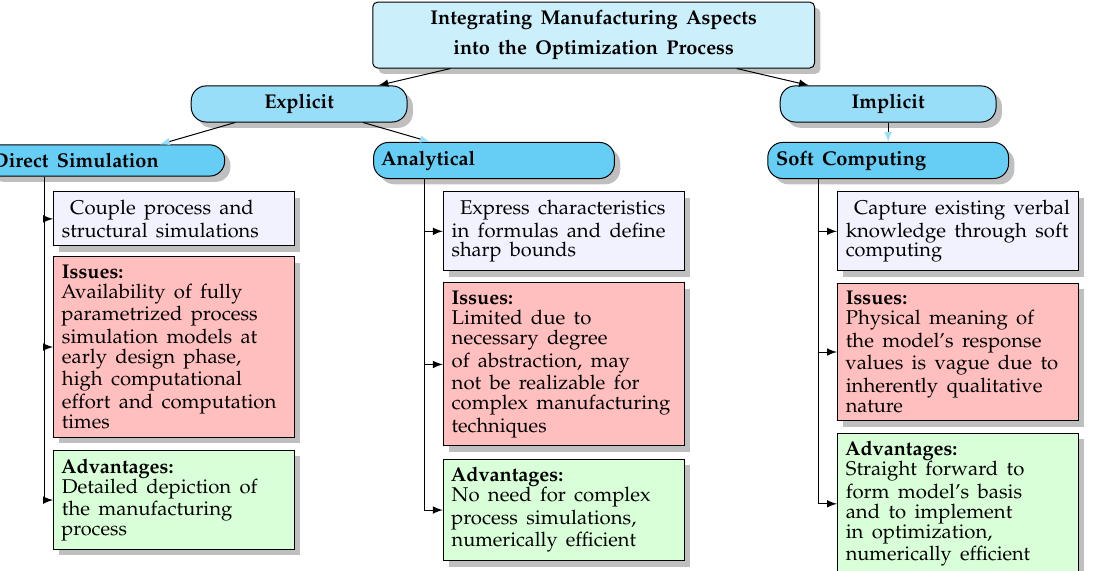
Figure 2. The three most frequent cases of capturing manufacturing aspects if they are to be introduced into the optimization